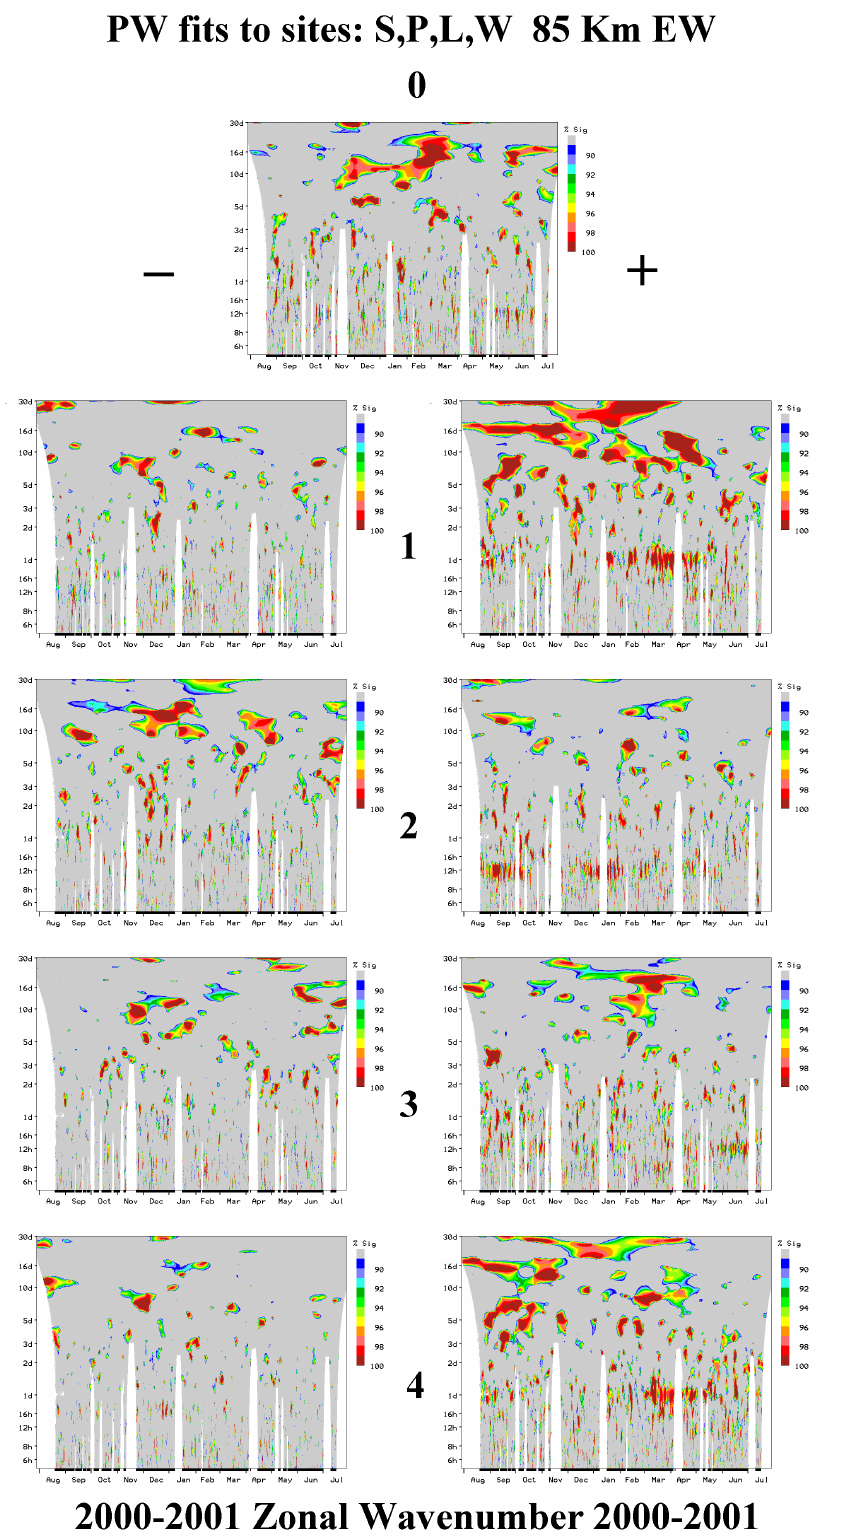
Fig. 4. Annual contours of the significance of the wave number fits as functions of frequency and time for the zonal (EW) component of the wind and for wave numbers from 0 to +/ − 4: the altitude is 85/86km. Largest numbers (99–100%) indicate best fitting between the wave number model and the data from the 4 middle latitude locations (London, Saskatoon, Platteville and Wakkanai) in comparison with randomly selected test data; see Sect. 2 for details of the